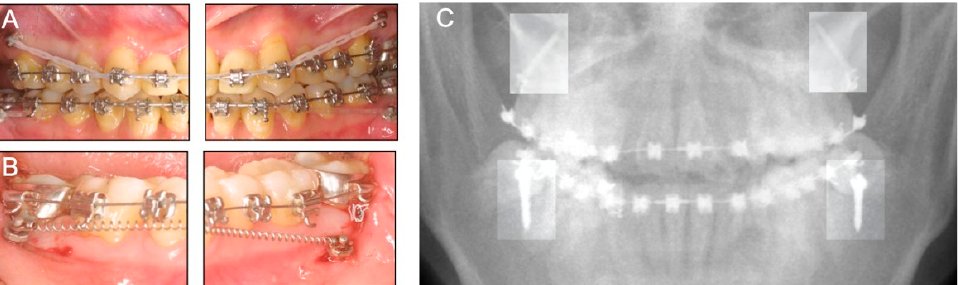
Figure 19. Extra-radicular positions of the TSADs at ( A ) infra-zygomatic crests and ( B ) buccal shelves are important for full arch distalization. The PA cephalogram ( C ) clearly shows the positions of the TSADs outside the dental roots.